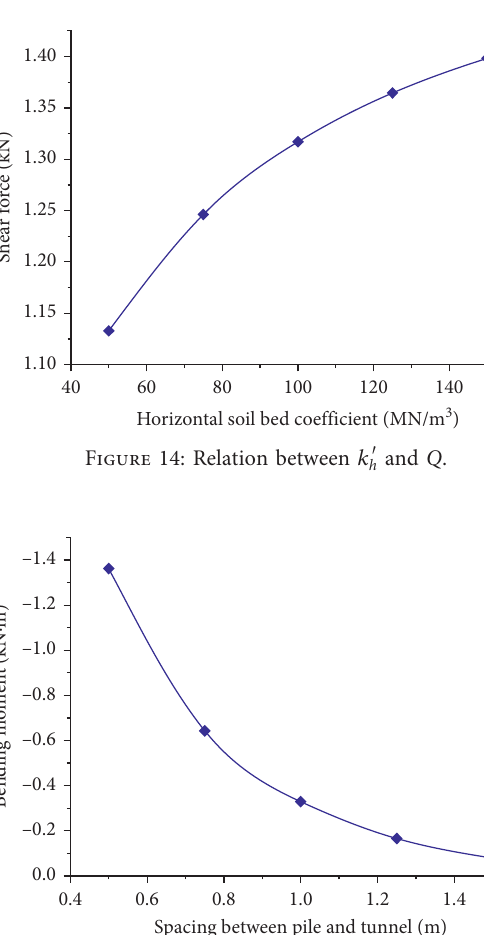
Figure 15: Relation between S and M .